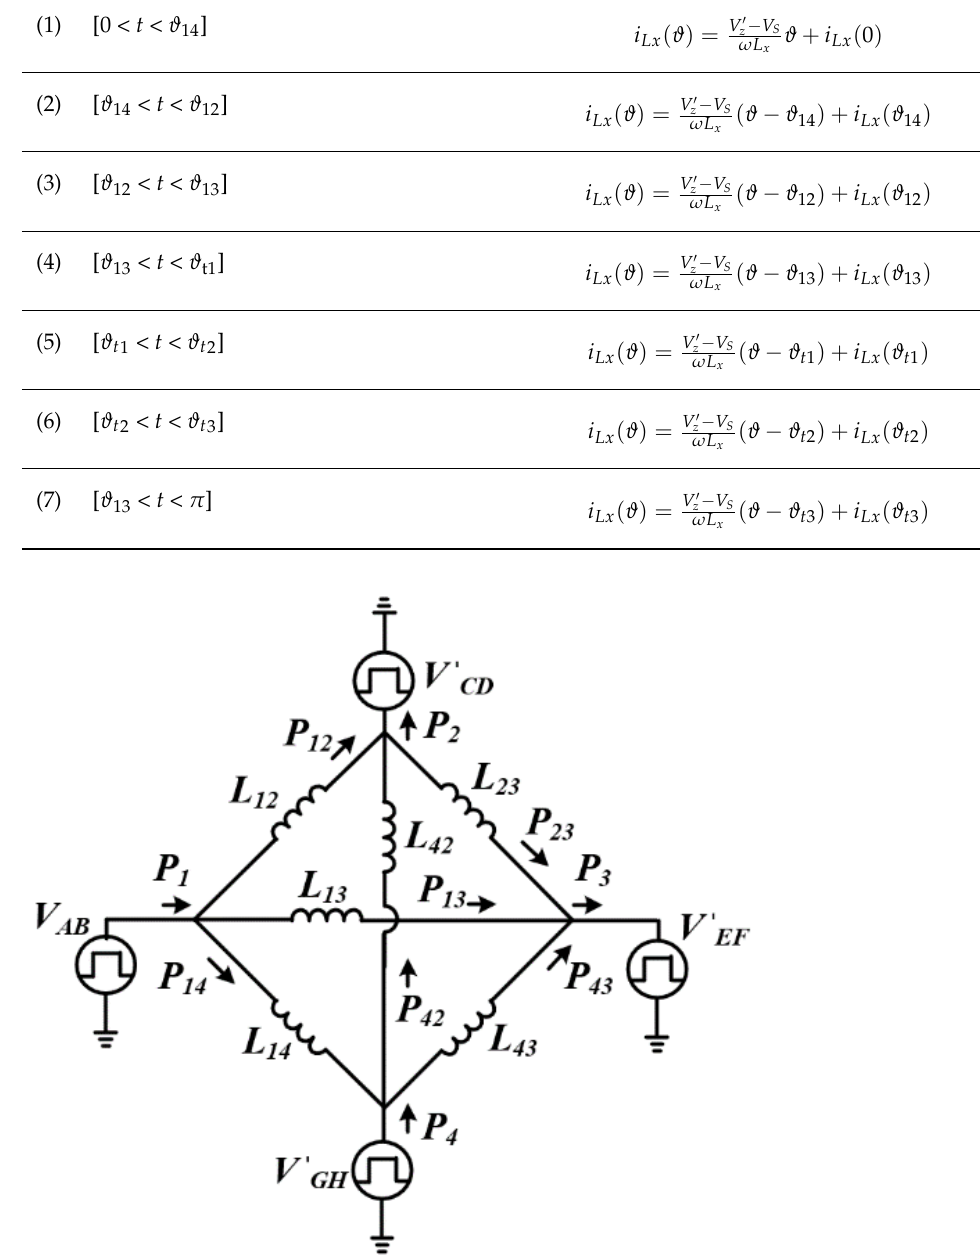
Table 2. Inductance currents into different time-intervals, with x ∈ {1, 2, 3, 4}. Time-Inteval, [0, π ] Inductor Current